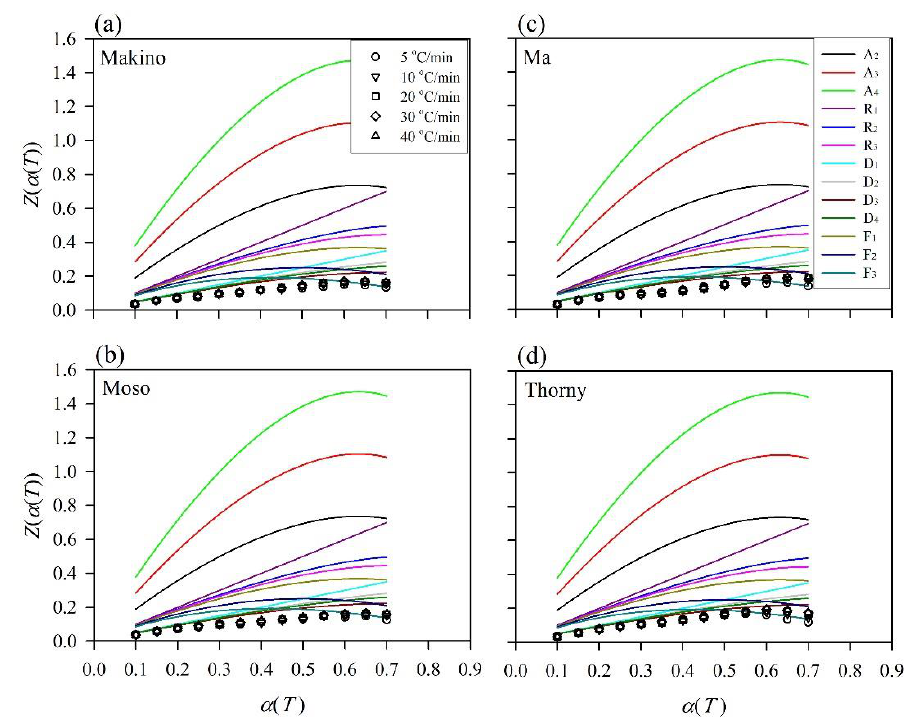
Figure 4. Master curves of kinetic models and experimental data obtained from the Criado method for various BFs. ( a ) Makino, ( b ) Moso, ( c ) Ma, and ( d ) Thorny.